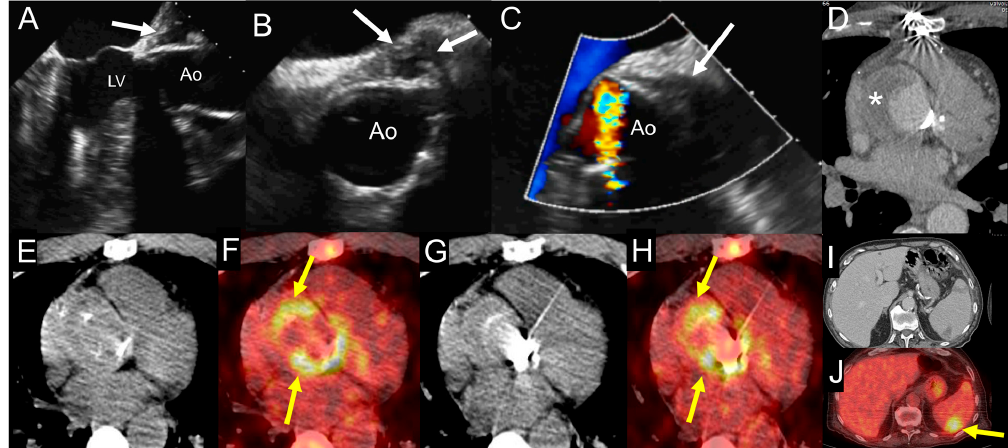
Figure 7. Example of the use of multimodality imaging. A patient with history of aortic valve replacement with mechanical prosthesis and ascending aorta graft presented four years later with acute right lower limb ischemia due to occlusion of proximal fibular, anterior tibial, and posterior tibial arteries treated with revascularization attempts and finally leg amputation. During hospitalization, the patient had fever with increased erythrocyte sedimentation rate and C-reactive protein. TTE ( A ) and at TOE ( B , C ) show the presence of hyperechogenic periprosthetic area (white arrows), most likely consistent with abscess. Blood culture was negative. The fluoro-18-fluorodeoxyglucose positron emission tomography / computed tomography (( 18 F)FDG PET / CT) exam including CCTA ( D – J ) was performed showing an organized fluid perigraft collection surrounded by thick walls (asterisk) that enhance after iodinated contrast injection on CCTA images ( D ), which is associated to intense uptake of ( 18 F)FDG around the aortic valve prosthesis, as shown by the yellow arrows (( E , G ) show noncontrast CT transaxial images while ( F , H ) show the fused PET / CT images). Myocardial suppression of ( 18 F)FDG of spleen uptake, consistent with septic embolism (( I , J ), noncontrast CT and fused PET / CT transaxial images, respectively), as indicated by the yellow arrow. Ao: ascending aorta; LV: left